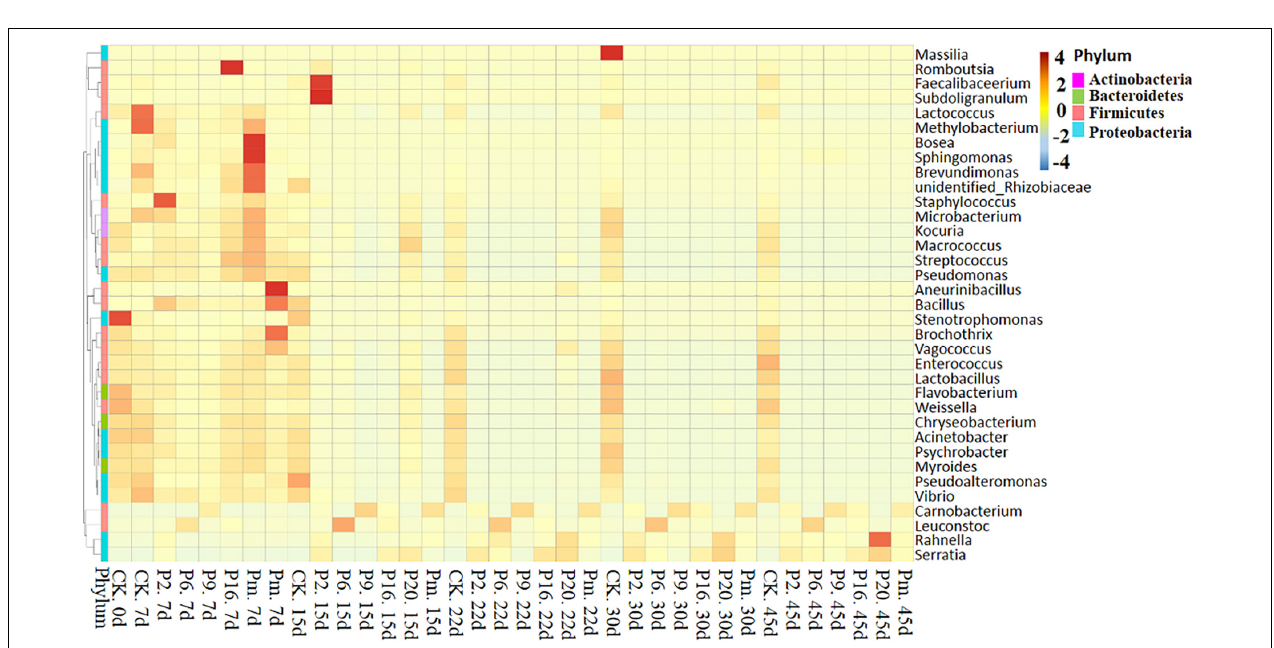
FIGURE 3 | Dynamics in relative abundance (%) of bacterial taxa at the genus level in bacon inoculated with potential spoilage bacteria. Each bar represents the relative abundance of each group, below the top 30 abundance (at genus level) data were merged. CK, Control; P2, Staphylococcus xylosus ; P6, Leuconostoc mesenteroides ; P9, Carnobacterium maltaromaticum ; P16, Leuconostoc gelidum ; P20, Serratia liquefaciens ; Pm, The five strains in combination.